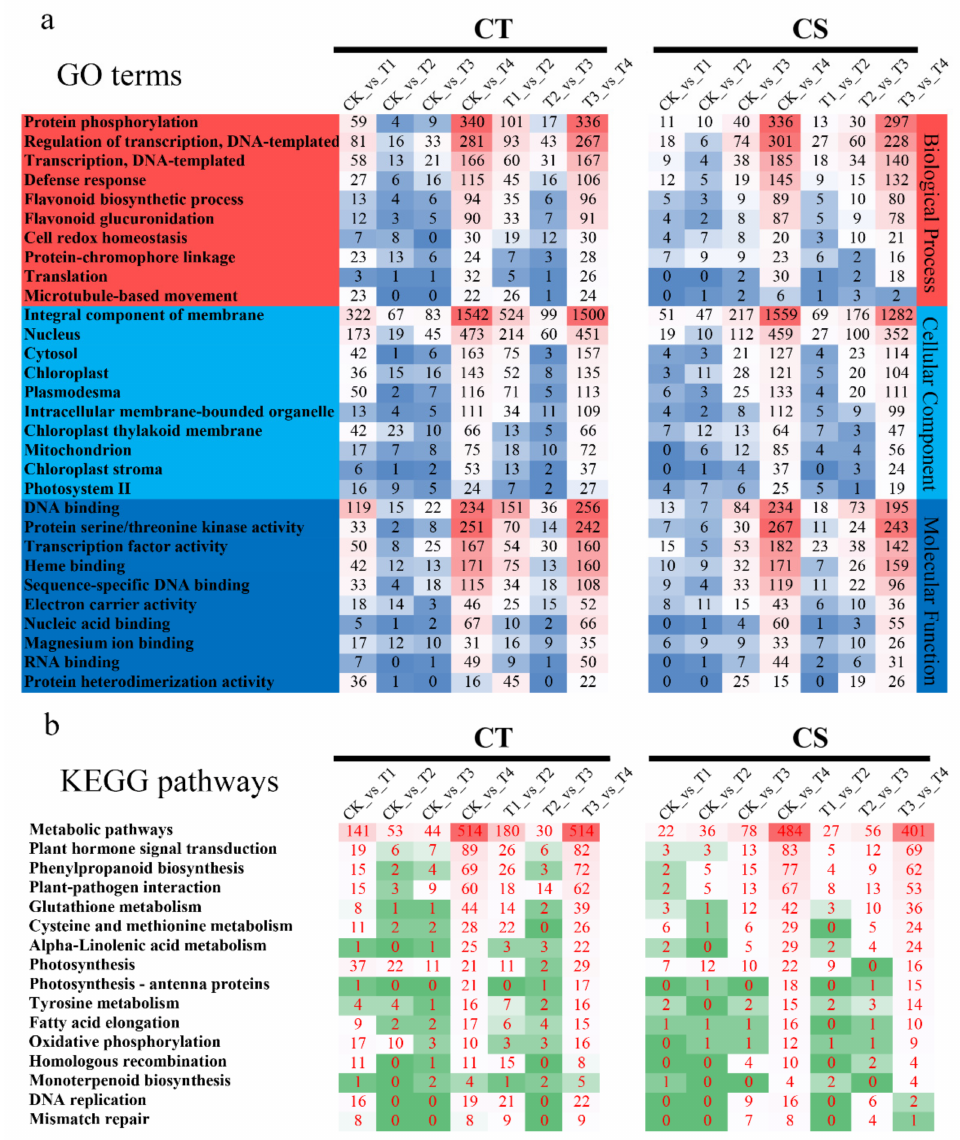
Figure 3. GO terms and pathways were significantly enriched in pepper under cold–rewarm treat- ments. ( a ) Significant enrichment of GO terms in the cold treatment groups. Deep red represents the higher number of DEGs, Deep blue represents the lower number of DEGs. ( b ) Significant enrichment of KEGG pathways in the cold treatment groups. Deep red color represents the higher numbers of DEGs; deep green color represents the lower numbers of